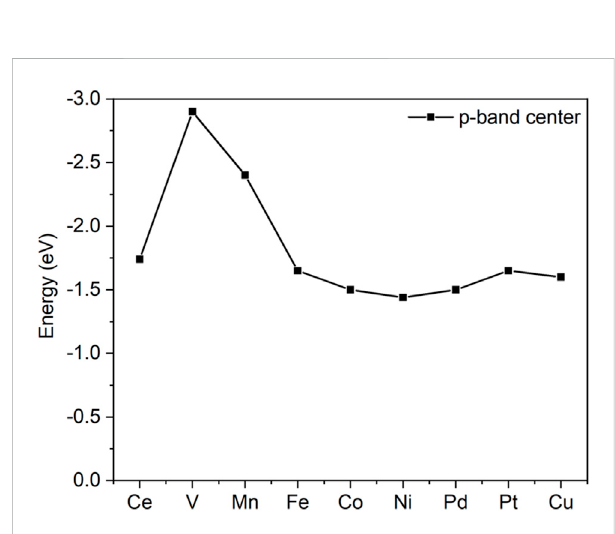
FIGURE 3 p-bandcentersofthesurfaceoxygenofdopedandpristineceria.